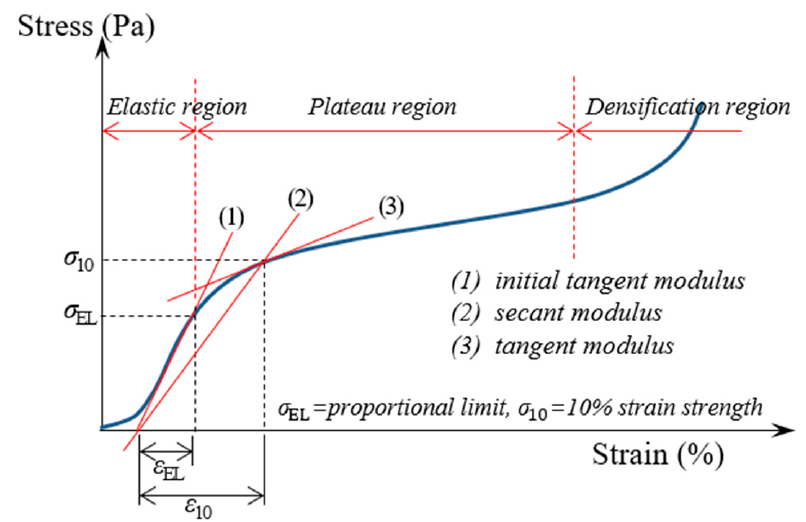
Figure 2. Typical SS curve and elastic modulus of EPS.